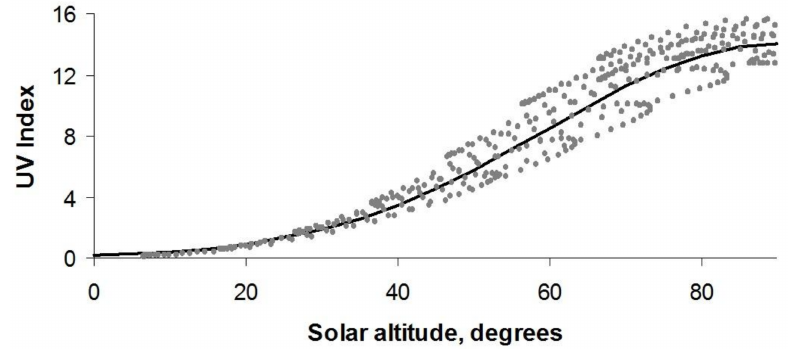
Figure 6. The variation of UV Index with solar